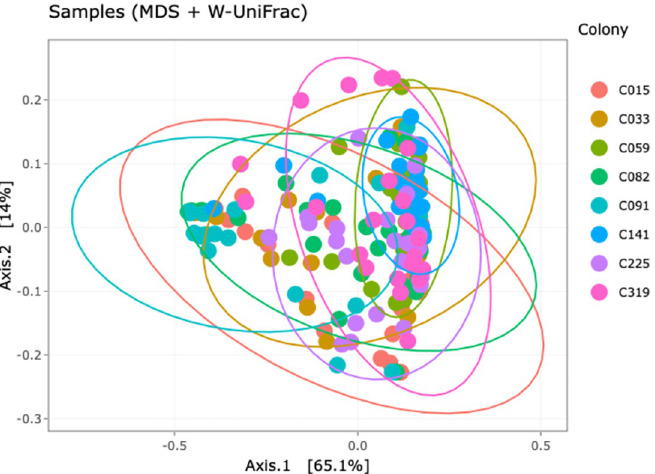
Fig 3. Ordination (multidimensional scaling, MDS) of microbiota samples by colony. Shown are the two primary axes (Axis.1, Axis.2) of a Principal Component Analysis (PCoA), based on weighted unifrac distances ( wuf ) between zOTUs. Numbers in brackets indicate percentage of total variation explained by the axis. Colours indicate colony (legend on the right). Samples (n = 7) with less than 10,000 reads were not considered. Colony 141 (C141, in blue) seems somewhat apart from the others, but no significant differences exist among